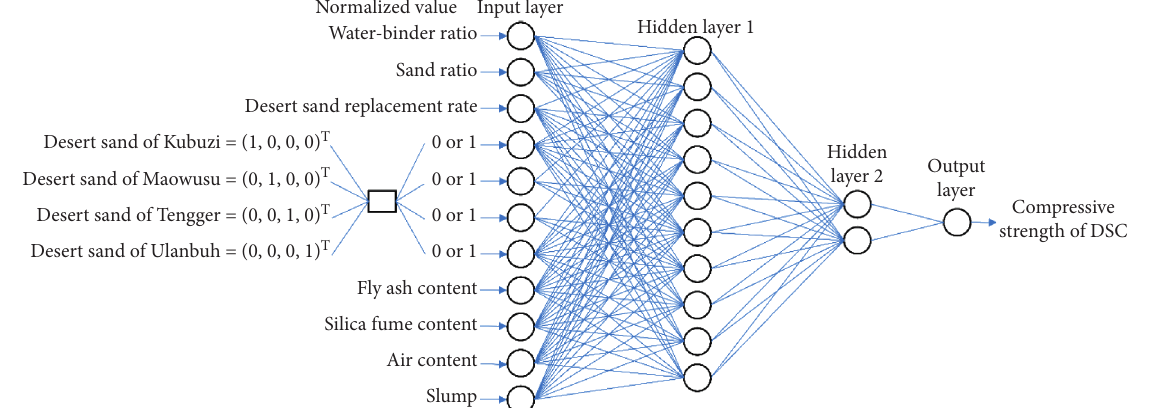
Figure 4: Architecture of the model.